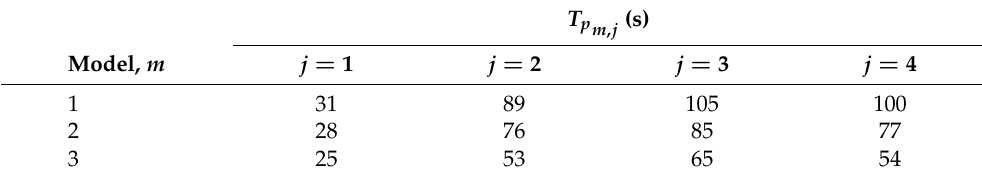
Table 4. Automated processing times input data.